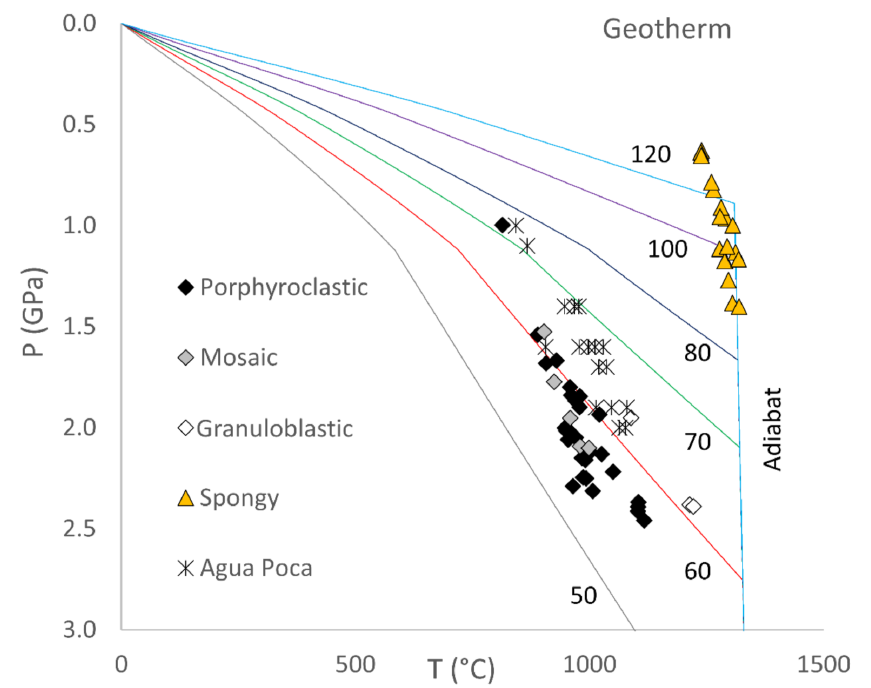
Figure 7. Pressure (GPa) vs. Temperature ( ◦ C). Temperatures were calculated with the two- pyroxenes geothermometer of Brey and Köhler [54] for primary pyroxenes and with equations of Wang et al. [58] for spongy clinopyroxenes. Pressure was calculated with the clinopyroxene geo- barometer of Mercier [53] for primary pyroxenes and with equations of Wang et al. [58] for spongy clinopyroxenes. For comparison, available data of mantle xenoliths from Agua Poca [10] were plotted together with geotherms calculated with the equations of Hasterok and Chapman [60] from 50 to 120 mW/m 2